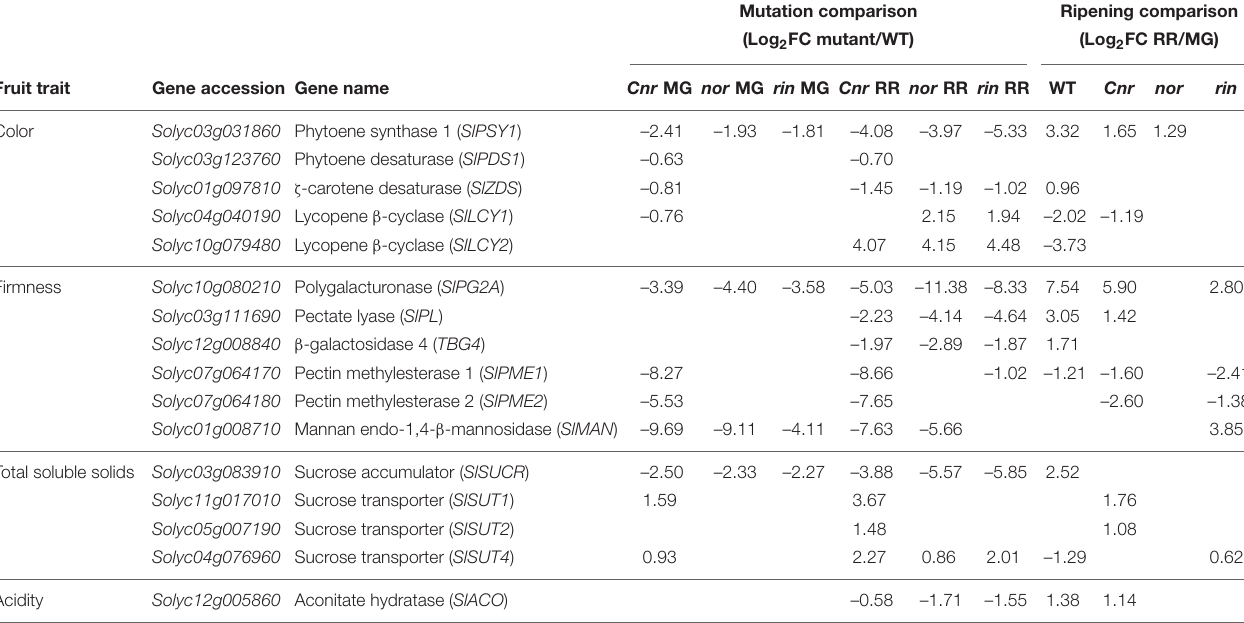
TABLE 1 | Differential expression of key genes associated with tomato fruit traits in the single ripening mutants Cnr , nor , and rin